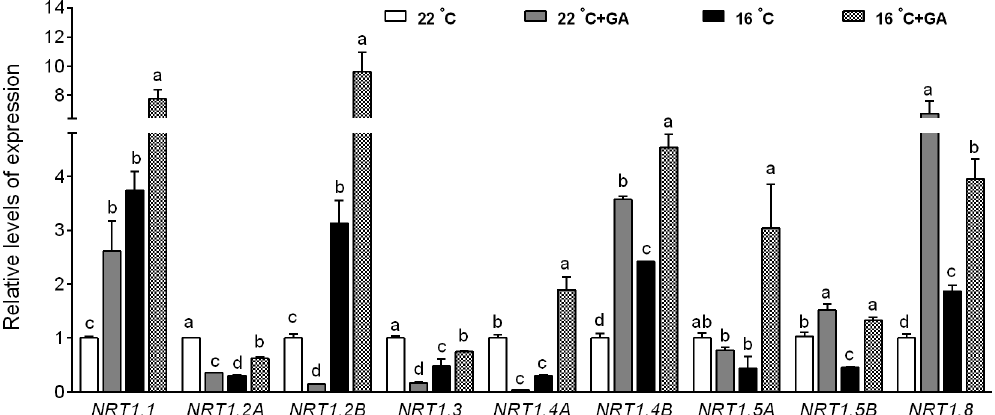
Fig 5. Suboptimal T r and GA regulate the transcript levels of CsNRT1 family genes. 15-day-old cucumber seedlings were transferred to 22°C T r and 16°C T r conditions in the presence or absence of GA 5 μ M GA for 8 d. The relative expression levels were analyzed by qPCR using Actin as internal control. Data are means ± SE. Different letters on the top of column indicate significant differences ( P < 0 . 05 , n =